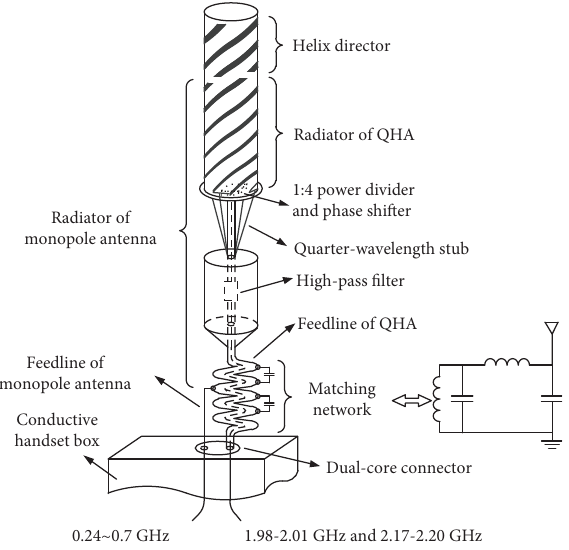
Figure 4: Geometry of the proposed